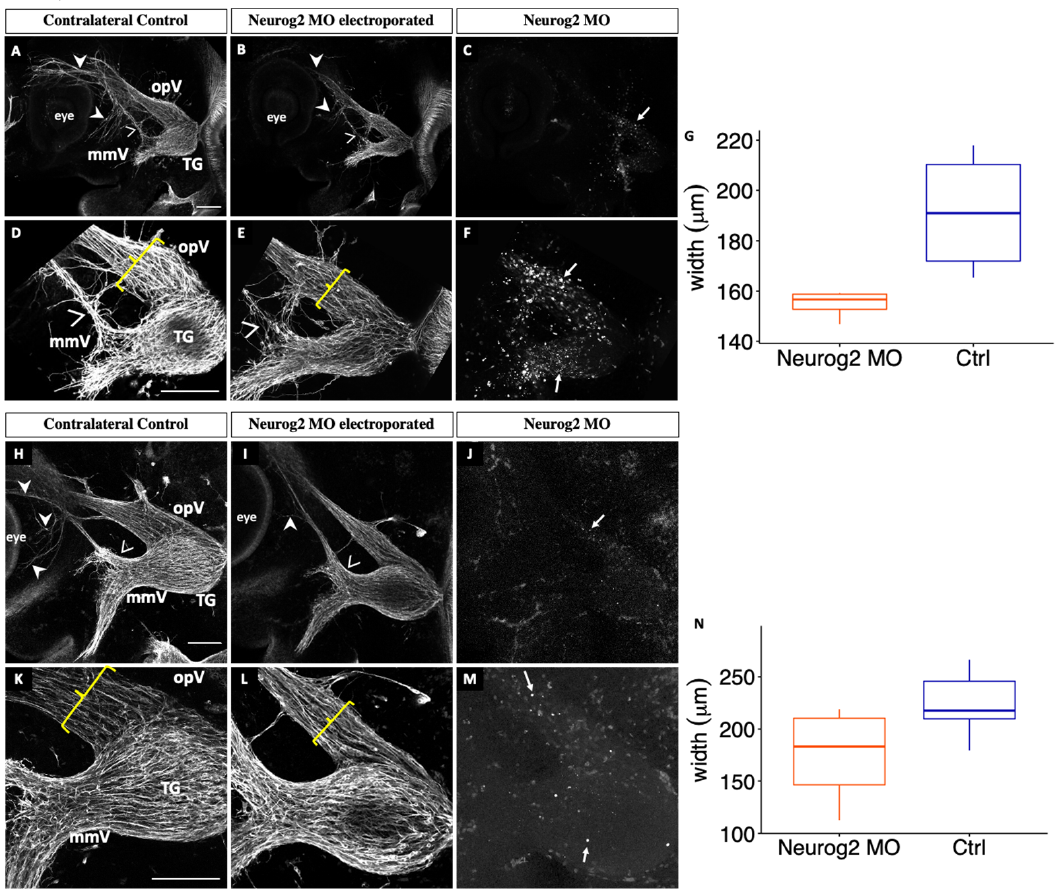
Figure 3. Depletion of Neurog2 in trigeminal placode cells impairs trigeminal ganglion development. Lateral view of the trigeminal ganglion in a chick head (E3 (HH18), n = 4, ( A – F ) and E3–3.5 (HH20), n = 6, ( H – M )). Representative images are maximum intensity projections of confocal Z-stacks through the contralateral control ( A , D , H , K ) and Neurog2 MO-electroporated ( B , E , I , L ) sides after processing for whole-mount Tubb3 immunohistochemistry to detect placode-derived neurons ( A , B , D , E , H , I , K , L , arrowheads) and tissue clearing. Bottom rows ( D – F , K – M ) show higher magnification images of their corresponding top rows ( A – C , H – J ). ( C , F , J , M ) MO-positive cells (arrows). Brackets indicate width of ophthalmic branch. ( G , N ) Quantification of the width of the ophthalmic branch on the control (blue) and Neurog2 MO-treated (orange) sides. Plots represent the median (center line), 75th percentile (top of box), and 25th percentile (bottom of box), with whiskers connecting the largest and smallest values. A paired sample t -test revealed p values of 0.05 ( G ) and 0.02 ( N ). Scale bar in ( A , D ) is 1 mm and applies to ( B , C ) and ( E , F ), respectively. Scale bar in ( H , K ) is 200 µ m and applies to ( I , J ) and ( L , M ), respectively. Abbreviations: mmV, maxillomandibular lobe; opV, ophthalmic lobe; and TG, trigeminal ganglion.